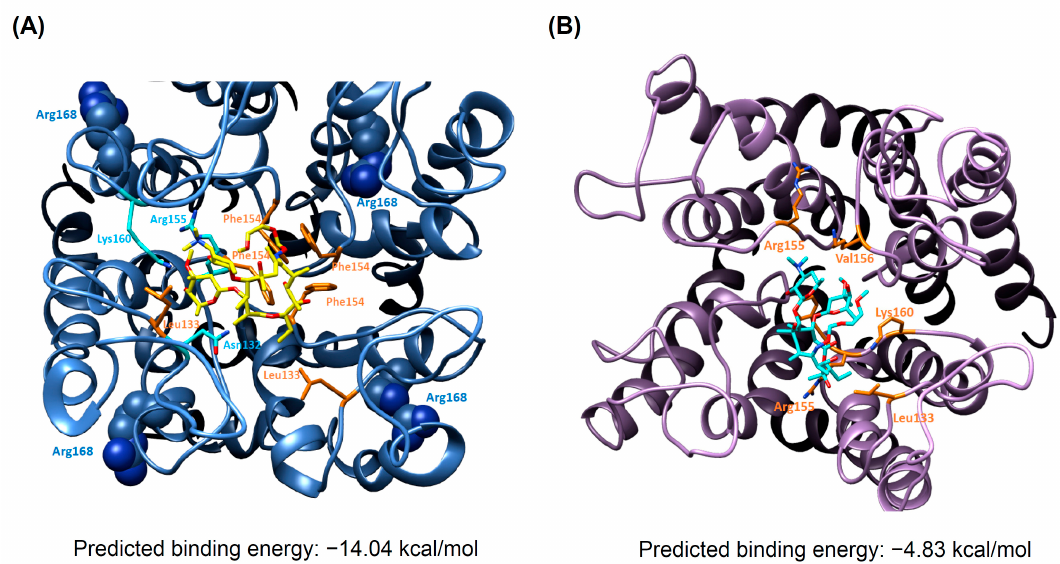
Figure 5. Docking analysis and molecular dynamics simulation of roxithromycin with mutant KCNJ5. ( A ) The binding 1 site analysis for Roxithromycin (Cyan) with L168R mutation of KCNJ5 after 1 ns MD equilibrium. Roxithromycin forms hydrogen bonding with Asn132, Arg155 and Lys160 (as shown in orange color residues). The hydrophobic effect was contributed by Leu133, and Phe154 (as shown in orange color residues). ( B ) The binding site analysis for Roxithromycin (Cyan) with KCNJ5 157-159delITE mutation of KCNJ5 after 1 ns MD equilibrium. Roxithromycin forms weak hydrophobic and hydrogen bond interaction with Leu133, Arg155, Val156 and Lys160 (as shown in orange color